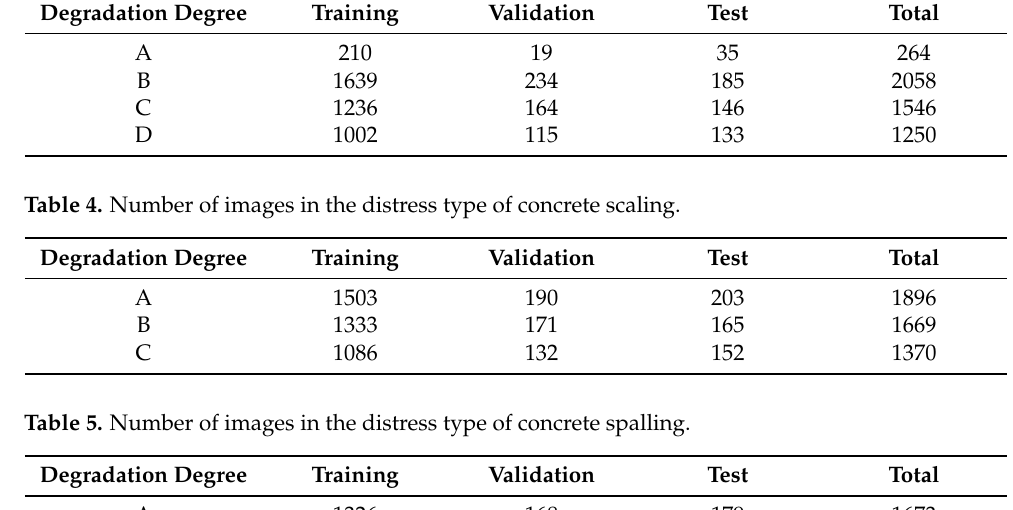
Table 3. Number of images in the distress type of rebar corrosion. Degradation Degree